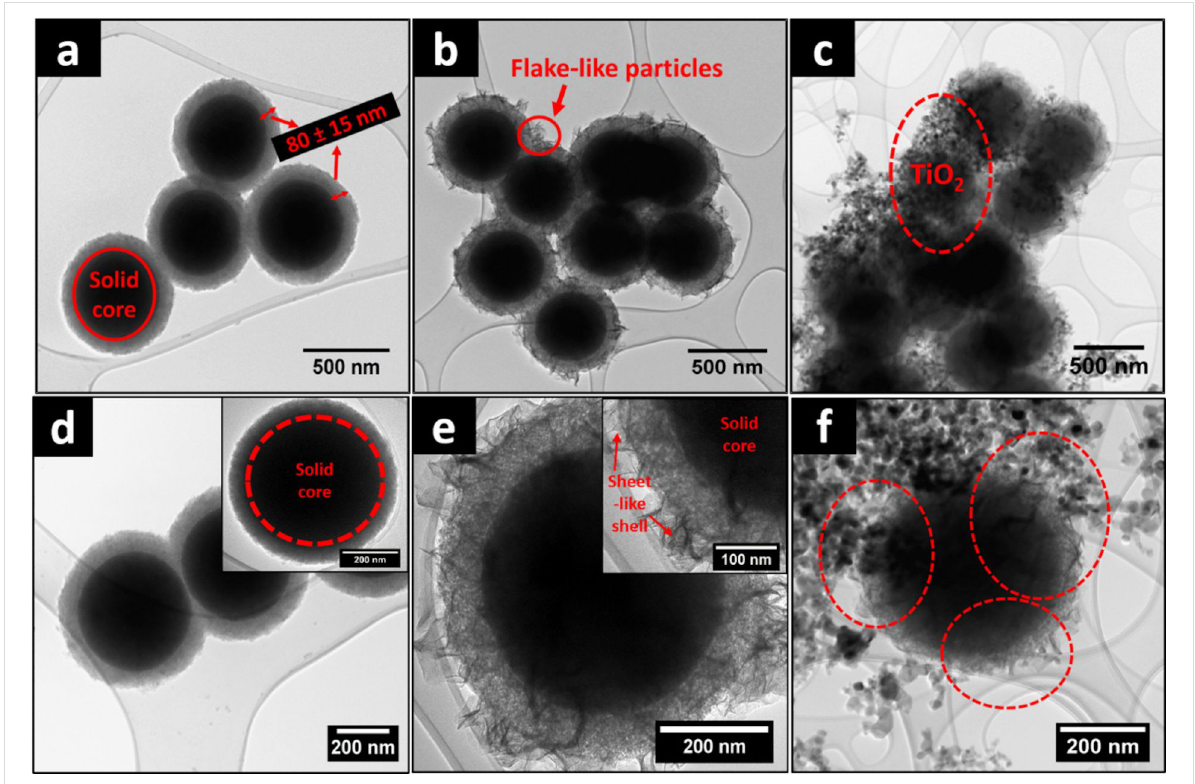
Figure 1: TEM images of (a, d) mesoporous SiO 2 , (b, e) mSiO 2 @NiPS, and (c, f) mSiO 2 @NiPS/TiO 2 .